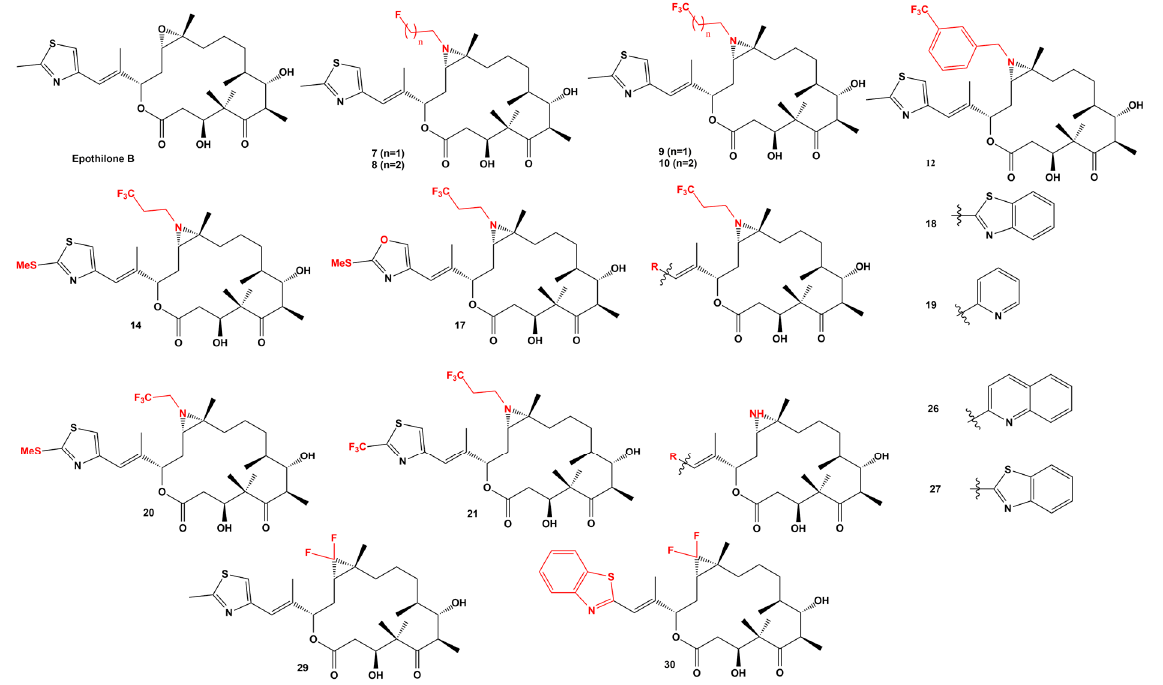
Figure 5. Chemical structures of the most active epothilone derivatives. These structures were published by [123]. Cytotoxic activities are reported in Table 4.